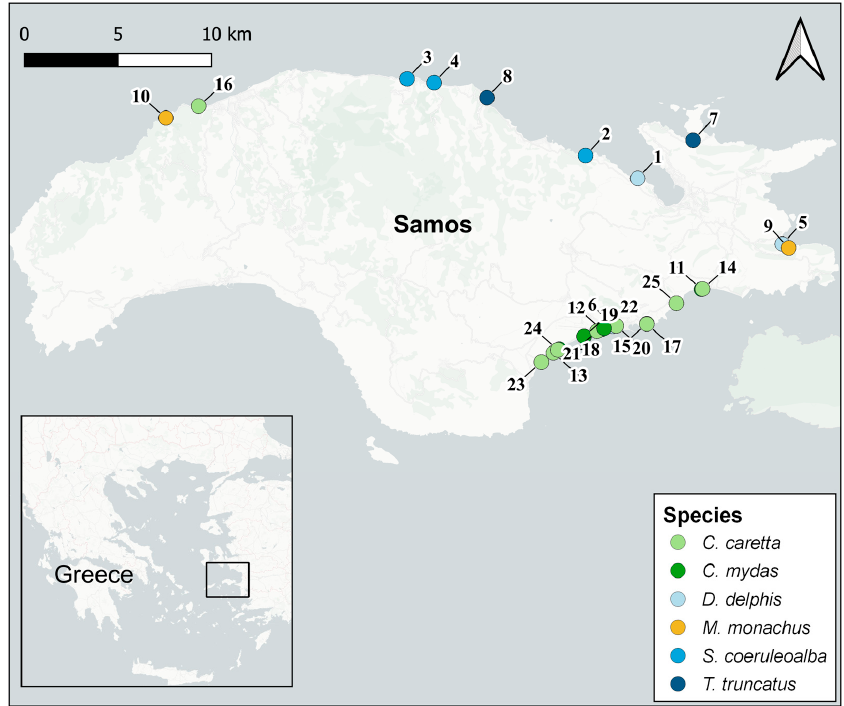
Figure 1. Distribution of stranded individuals along the shore of Samos Island. Point labels correspond to the ID column indicated in Table 1. Map generated using QGIS 3.16.1. Table 1. Summary of the specimens found stranded along the coast of Samos Island (Greece) during the period 2018–2019 (F: Female; M: Male; ND: Not Determined; -: Not Measured; MPs: expressed as the raw total number of particles identified in the GIT per individual).